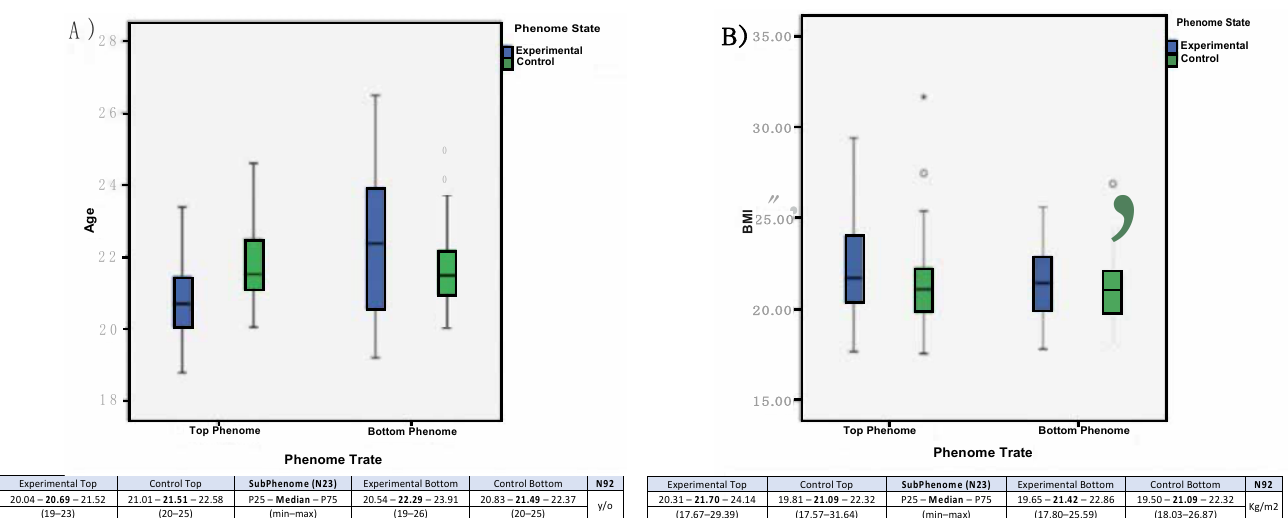
Figure 2. Biometric data of the neurotypical sample. In ( A ), a boxplot (P25, median, P75, minimum and maximum) of the sample’s age in the four subphenomes (Experimental Top subgroup, Control Top subgroup, Experimental Bottom subgroup, and Control Bottom subgroup) is presented. In ( B ), a boxplot (P25, median, P75, minimum and maximum) of the sample’s BMI (Body Mass Index), in kg/m 2 , for the same four subphenomes is presented.